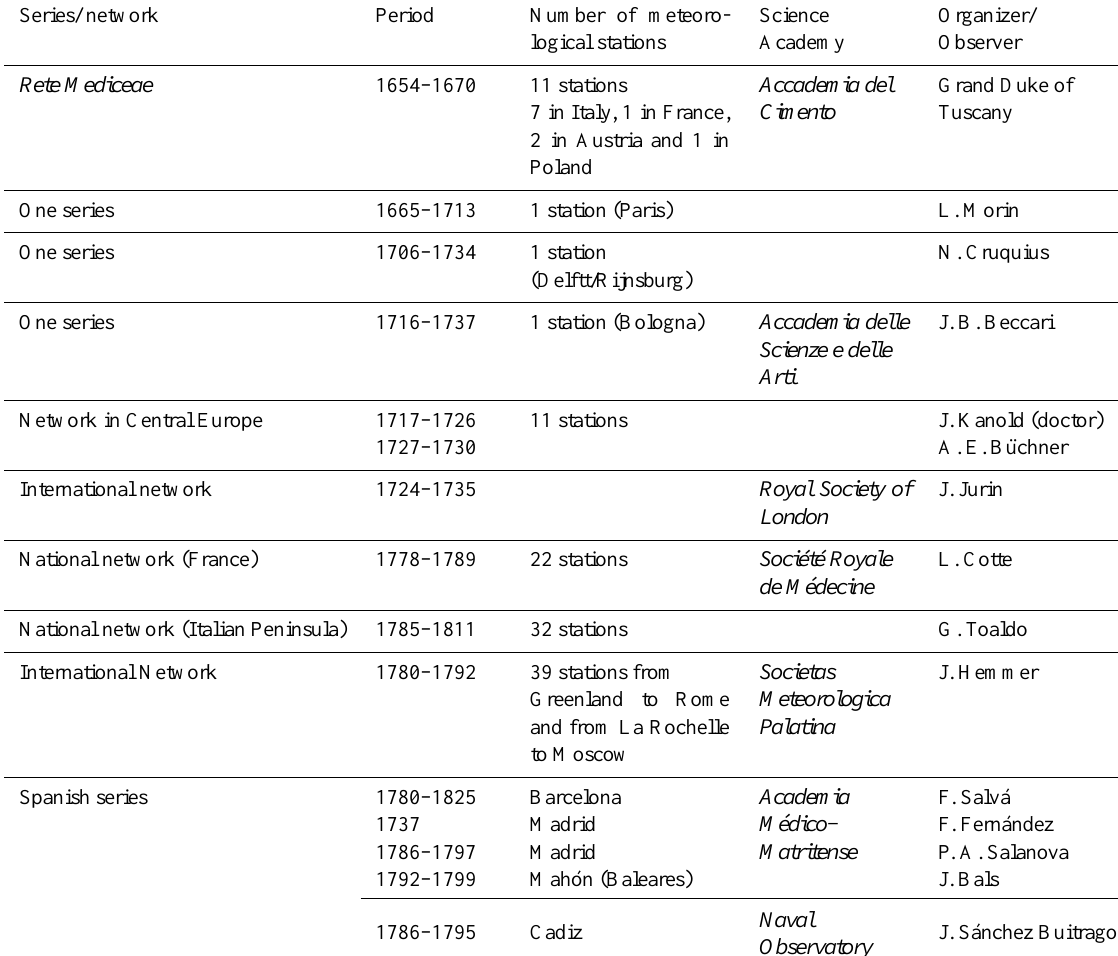
Table 1. Early short instrumental series in Europe (Sources: Kington, 1988; Jones et al., 1999; Pfister and Barreis, 1994; Camuffo, 2002a, b; Br´azdil et al., 2005; L¨udecke, 2010; Camuffo and Bertolin,